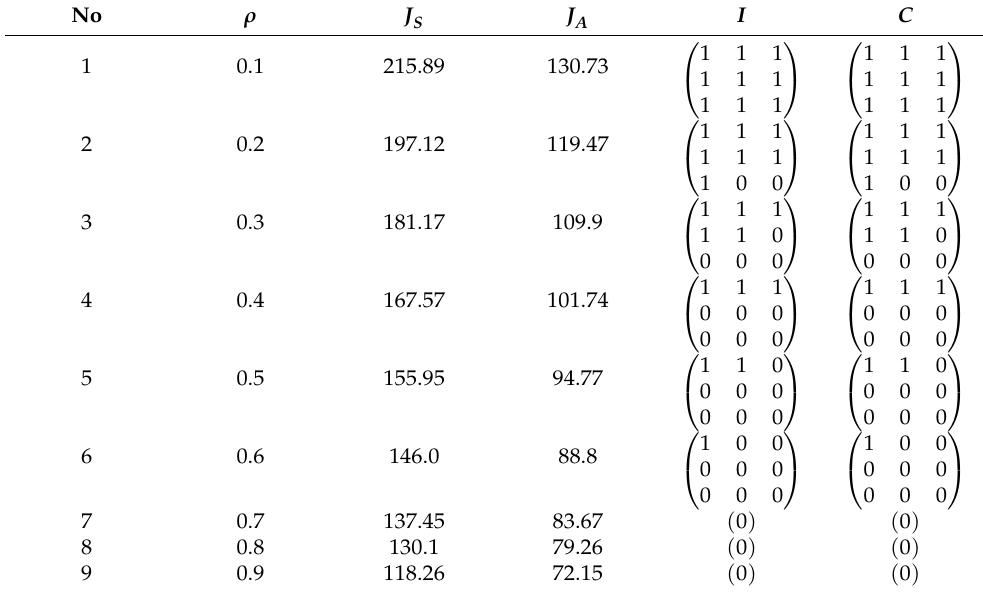
Table 6. Players’ optimal strategies and payoffs in dependence of the discount factor ρ